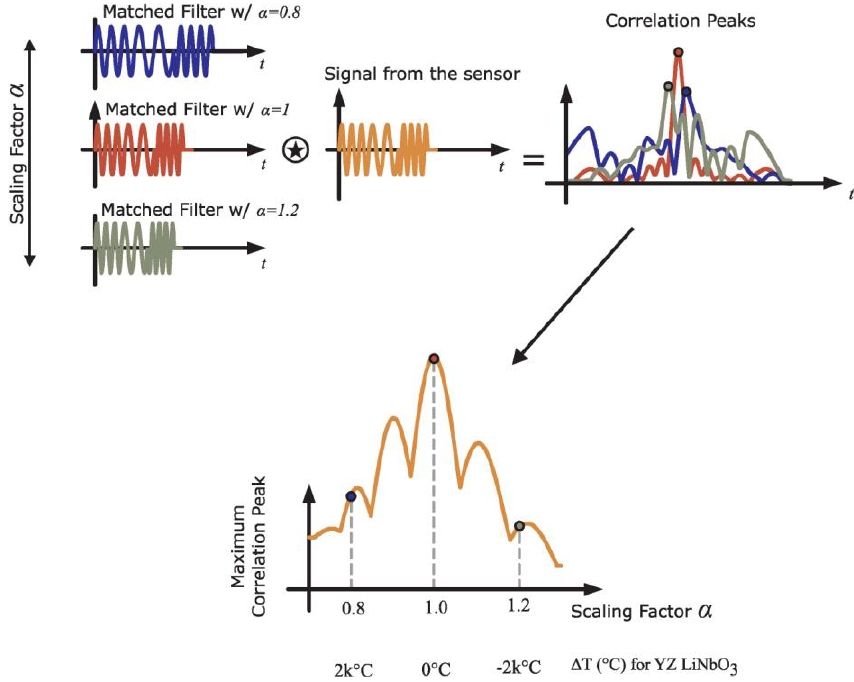
Figure 12. Principle of operation of the adaptive matched filter approach to maximize the correlation waveform and extract the SAW sensor temperature. The frequency scaling factor changes and matched filters are generated, examples shown for = 0.8, 1, and 1.2. The convolution of the matched filter with the sensor signal produces a correlation response. The peak of the correlation response is plotted versus and the maximum value is mapped back into temperature for a given